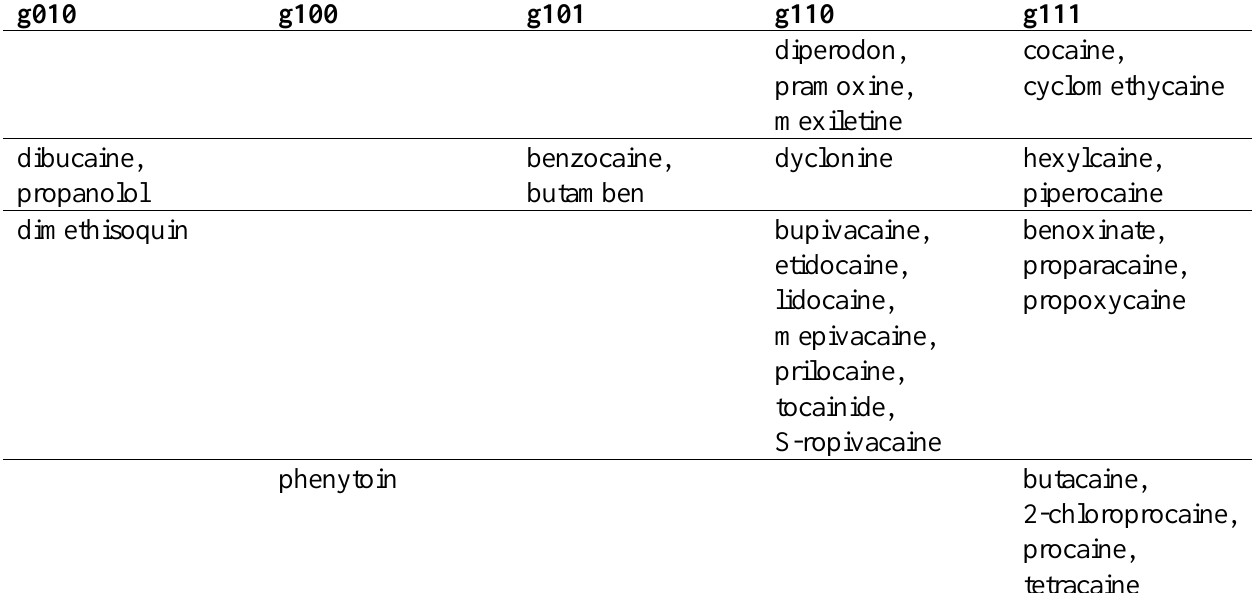
Table 7. Table of periodic properties for the local anaesthetics analogues of procaine. g010